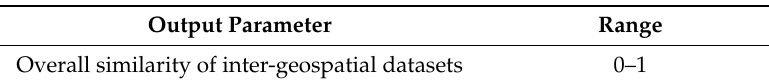
Table 7. Output parameters for our MLFFN and their ranges.